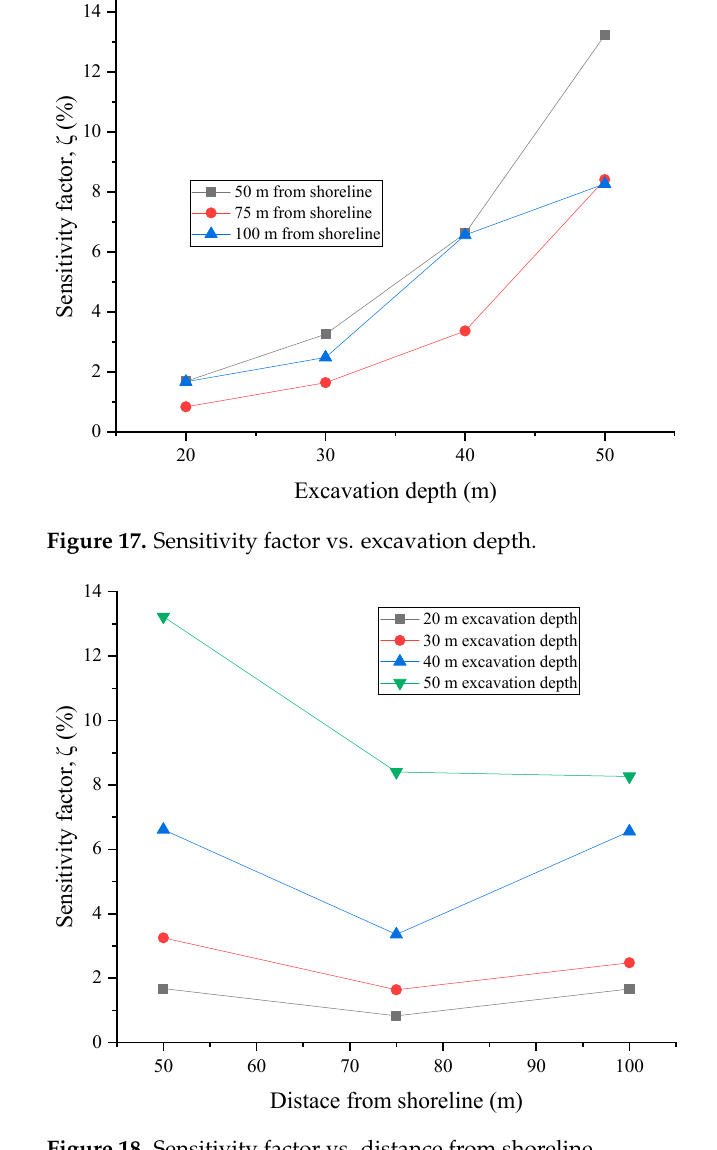
Figure 18. Sensitivity factor vs. distance from